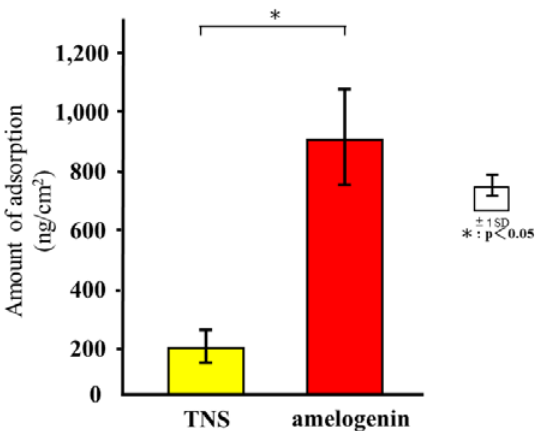
Figure 5. Quartz crystal microbalance (QCM) analysis of test and control groups. * p < 0.05.